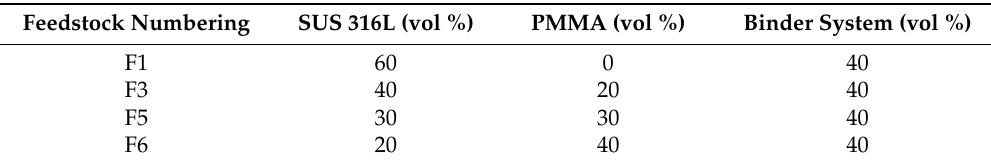
Table 5. Feedstocks with various PMMA space holder vol % with the fixed size (P2, 50 µ m) and their volume